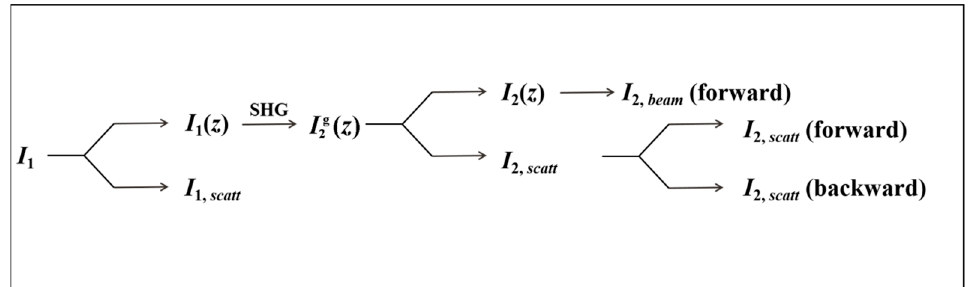
Figure 2. Second-harmonic generation (SHG) process diagram. Table 3. PolFact and nFact for each type of PM. Here, f is the volume packing fraction, T 1 represents the transmittance of fundamental light between medium and material, T 2 represents the transmittance of second-harmonic Optical light between medium and material, and I 1,0 is intensity of fundamental light at z = 0. Moreover, g ( r ) is the function of particle size, second-order susceptibility coefficients d ij , and refractive indices; ε o represents the vacuum dielectric constant; c is the light speed; and λ 1 is the wavelength of the fundamental wave. PolFact is the “polarization factor” and nFact is a function of the principal refractive indices of the material for the wavelengths involved {(n 1o , n 1e ), (n 2o , n 2e )}. This depends on the sign of the birefringence and the type